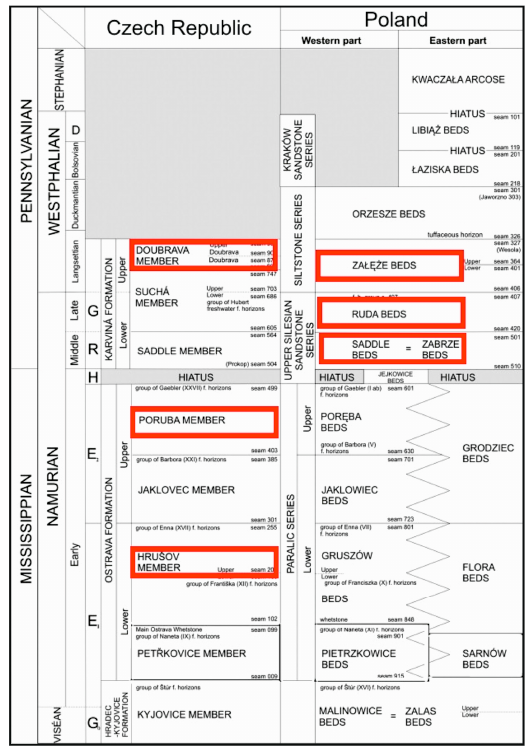
Figure 1. Lithostratigraphic division of the Polish and Czech parts of the Upper Silesian Coal Basin, according to [27], modified by [28] and [29] (Polish part), and [30] modified by [31] and [32] (Czech part). Modified. In red frames, lithostratigraphic formations from which the samples were taken for research are shown.